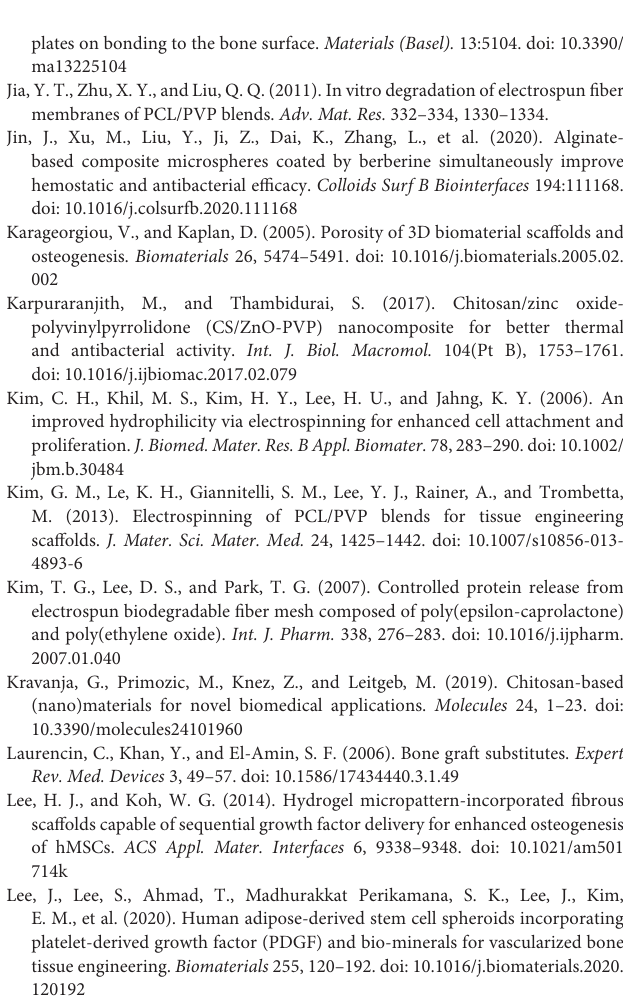
Supplementary Figure 1 | In vitro release